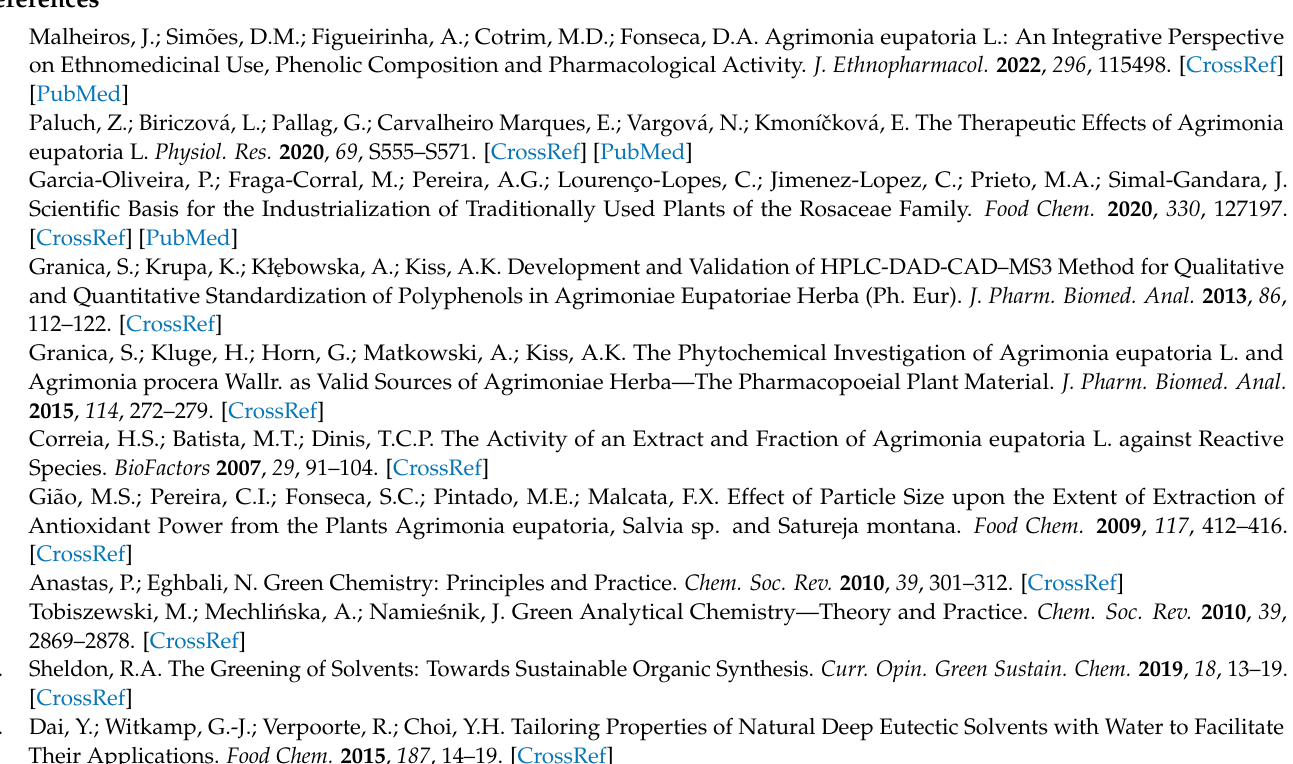
graph; Figure S2: The sigma profiles of isoquercetin and NADES 5 (choline chloride: glycerol 1:1). The surface charge density of isoquercetin is shown in the upper-left part of the